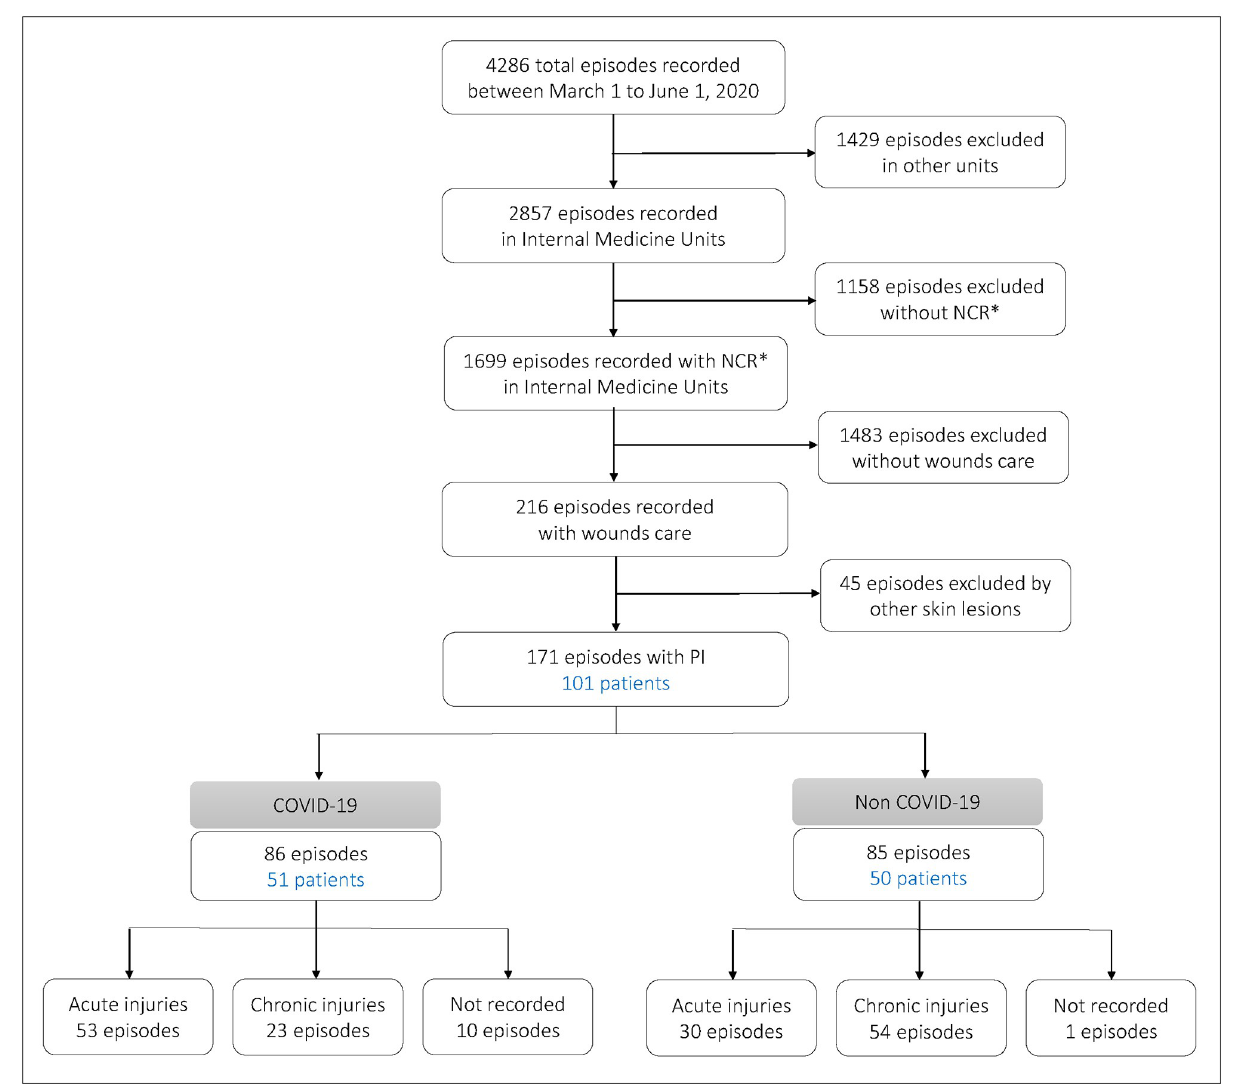
Fig 1. Flow diagram to show episodes recorded between March 1 and June 1, 2020. � NCR: Nursing Care Reports.